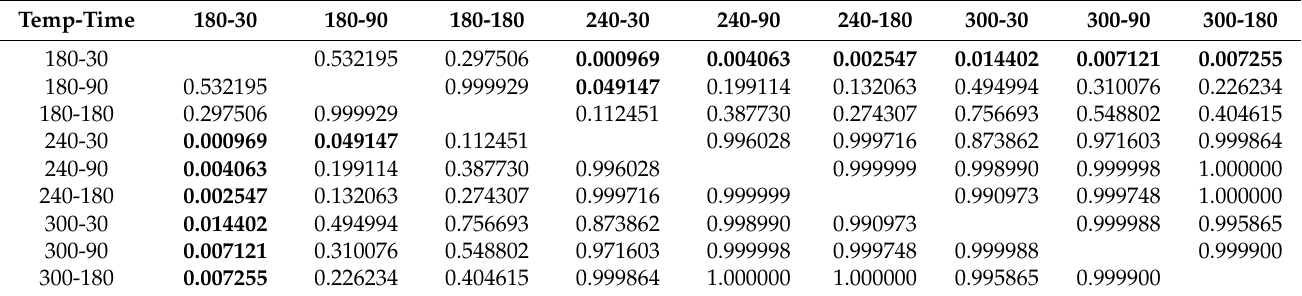
Table A6. Two-way analysis of variance (ANOVA) with post hoc Tukey test for EG , a bold font signifies a statistically significant difference ( p <